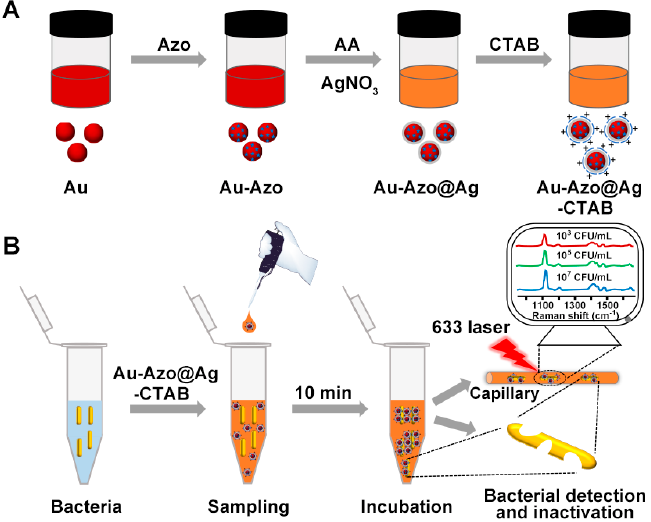
Figure 1. Schemes illustrating the ( A ) synthesis of Au − Azo@Ag − CTAB SERS nanotags and ( B ) the process of bacterial detection using the nanotags.